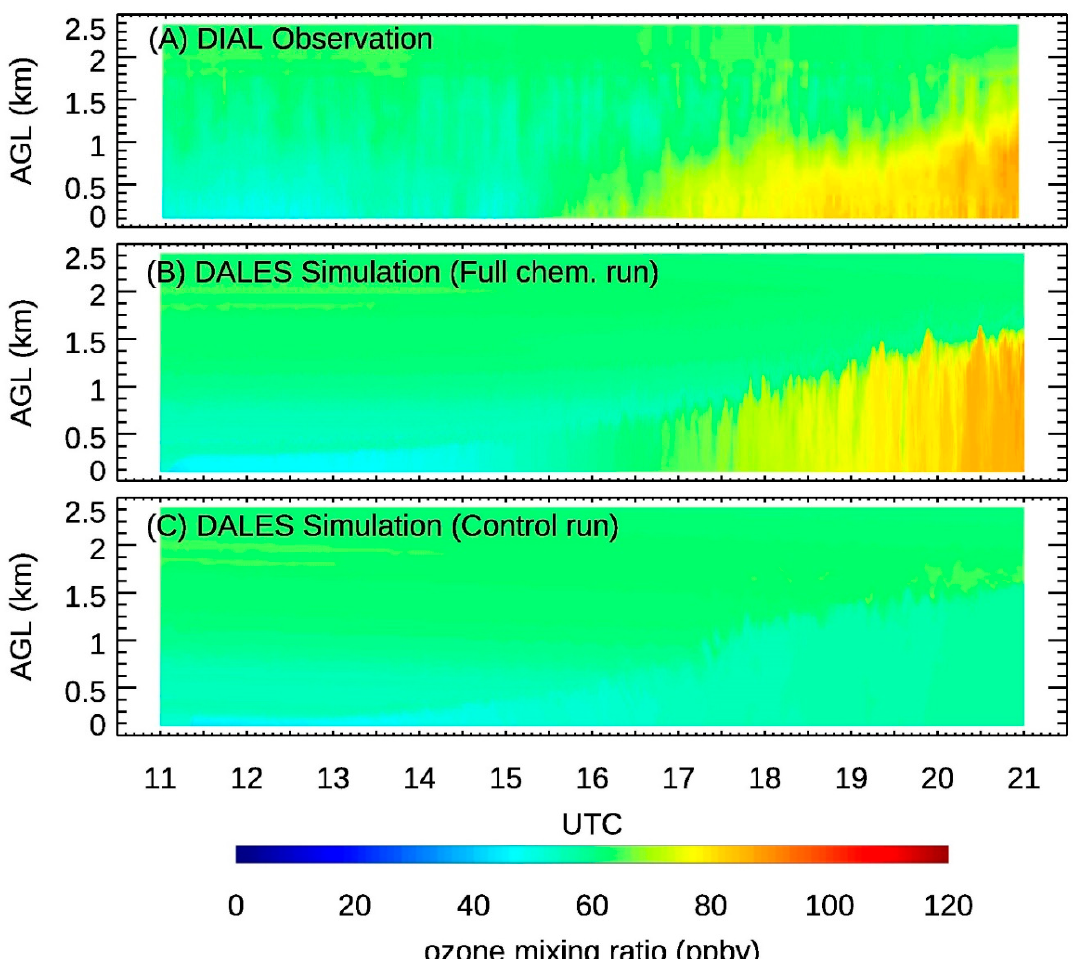
Figure 4. ( A ) Ozone profiles observed by ozone DIAL, ( B ) simulated of DALES with full chemistry run, and ( C ) simulated by DALES in the control run without chemistry or dry deposition.